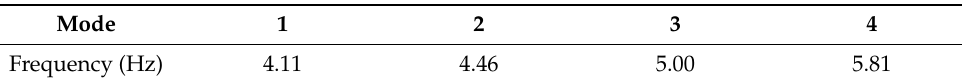
Figure 3. First four modes of the NPP. Table 1. First 4 modes of the NPP.